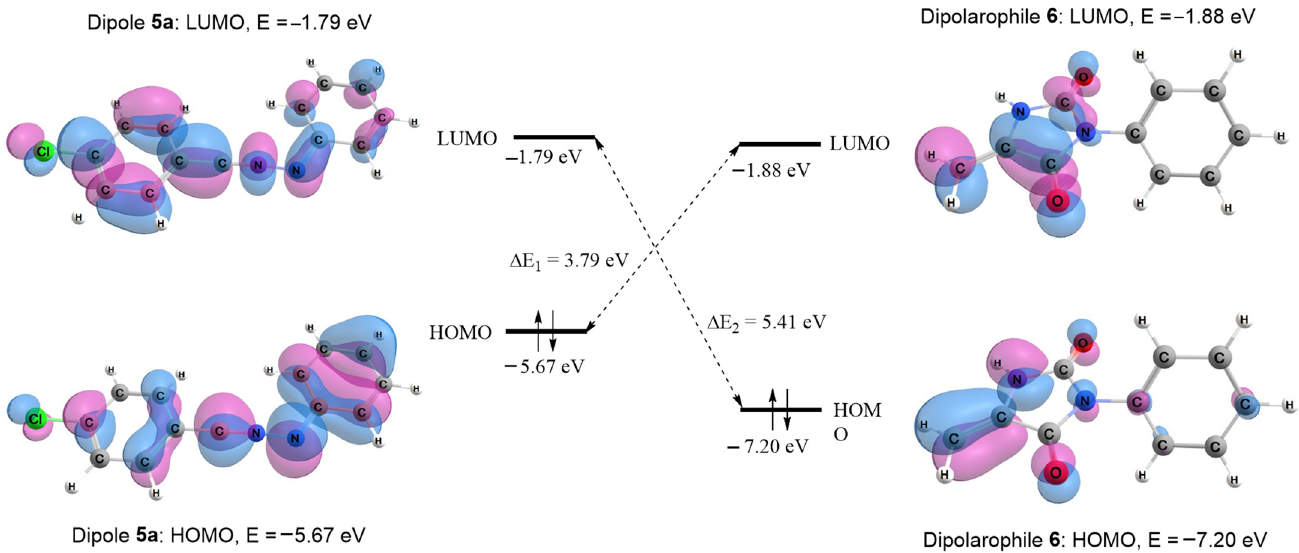
Figure 1. Optimized geometries, visualized FMOs, and graphical illustration of the HOMO-LUMO interaction of nitrile imine 5a and 5-methylidene-3-phenylhydantoin 6 . Table 2. Calculated HOMO–LUMO gaps for nitrile imines 5a, j-l , and dipolarophile 6 . LUMO,